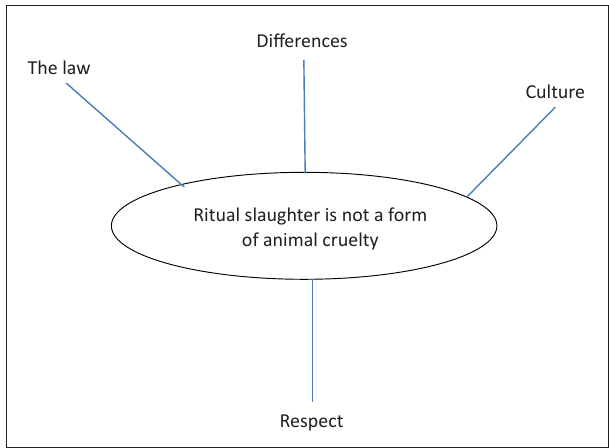
FIGURE 1: Busi’s brainstorm for the argumentative essay.